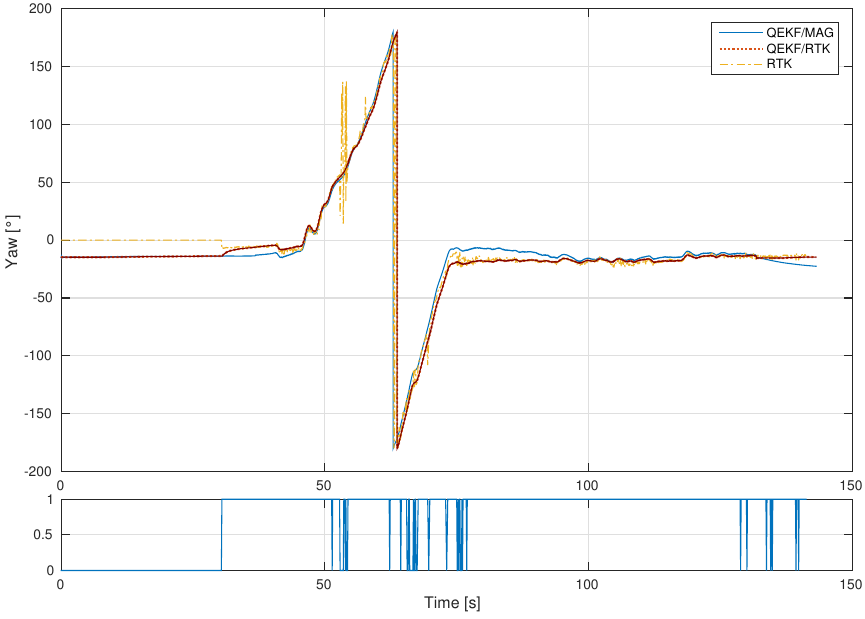
Figure 9. Heading estimation during flight: magnetic- and GPS-based solution; update